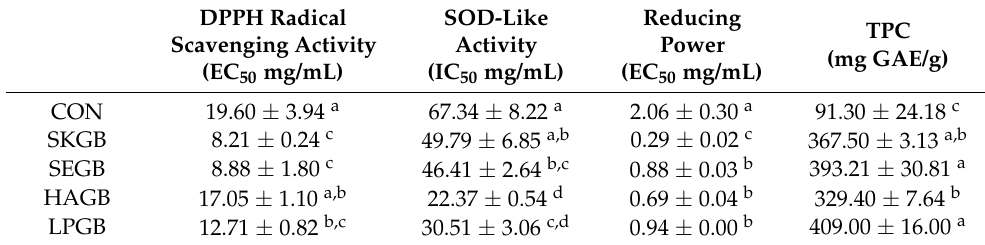
Table 3. Antioxidant activity and total phenolic compounds of fermented